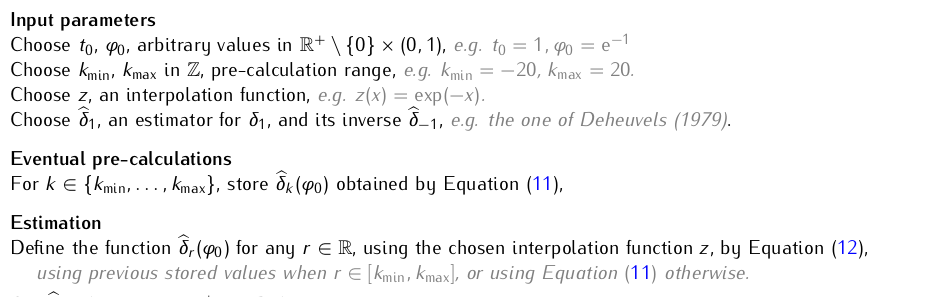
Algorithm 2 Detailed procedure for non-parametric estimation of generators of Archimedean